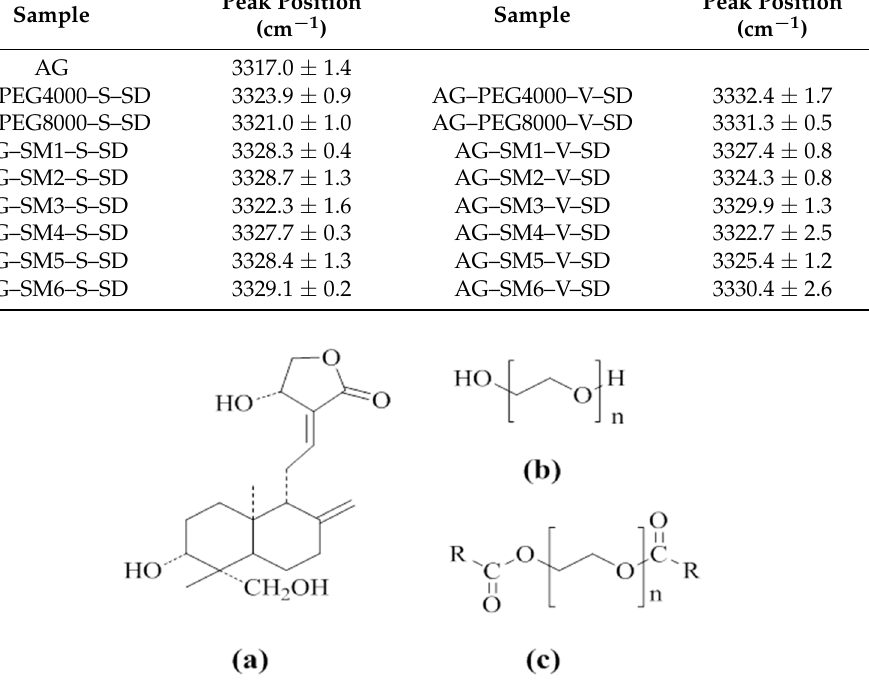
Figure 1. Molecular structures of andrographolide (AG) ( a ), polyethylene glycol (PEG) ( b ), and PEG grafted with carbon chains ( c ): R = C 11 H 23 in PEG4000 laurate (SM1) and PEG8000 laurate (SM4), R = C 15 H 31 in PEG4000 palmitate (SM2) and PEG8000 palmitate (SM5), R = C 22 H 45 in PEG4000 behenate (SM3) and PEG8000 behenate (SM6).